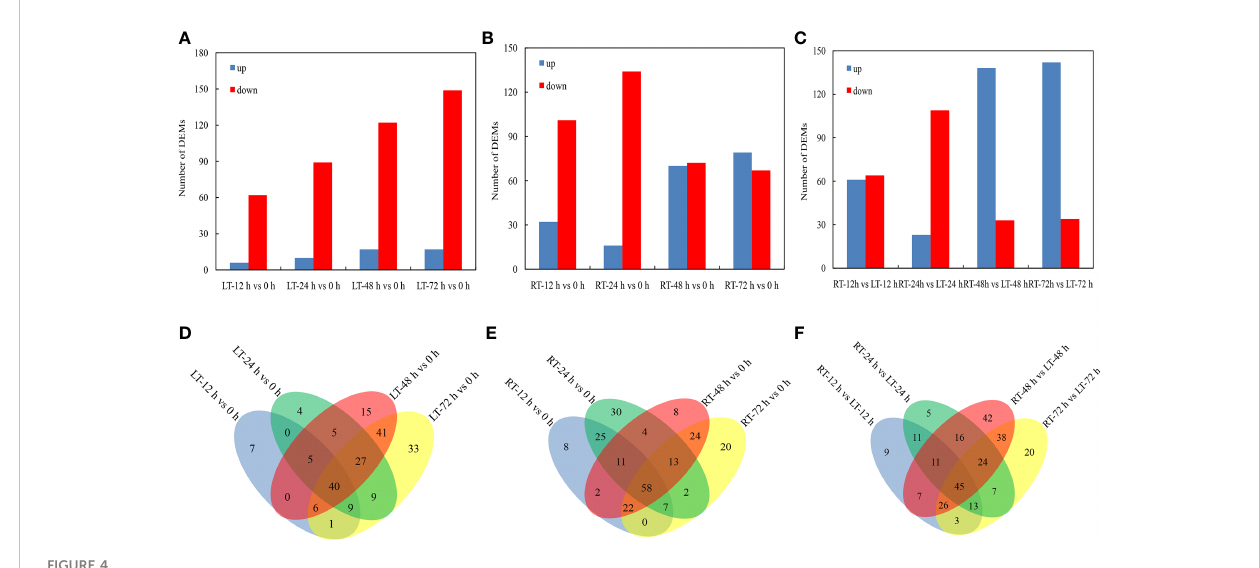
FIGURE 4 Distribution of DEMs at different storage times after harvest. Identi fi cation and number statistics of DEMs based on VIP > 1 and P < 0.05 (A – C) . According to Venn diagram analysis, the DEMs overlapped at different times under RT and LT storages after harvest (D – F)